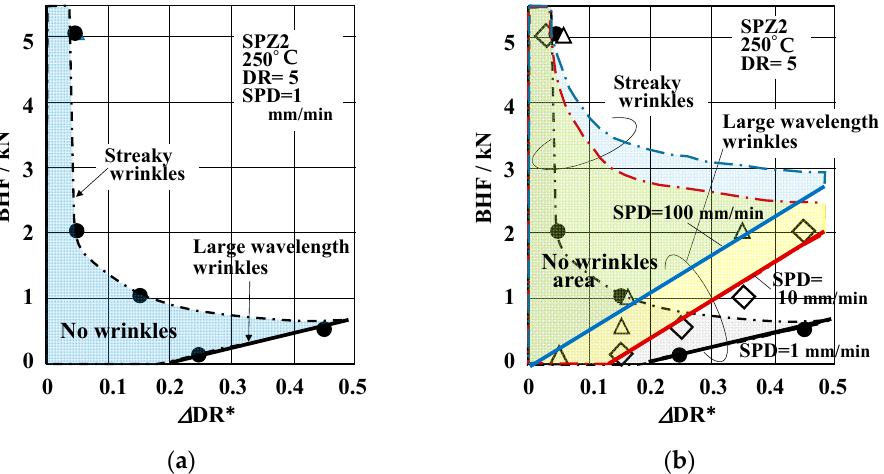
Figure 4. Effects of BHF and SPD on the occurrence of flange wrinkles under constant BHF and SPD in warm superplastic deep drawing (DR = 5). 〇 : SPD (mm/min) = 1, ◇ : SPD = 10, △: SPD = 100, solid line: large wavelength wrinkle mode, dashed line: streaky wrinkle mode. ( a ) Wrinkle limit diagram at SPD=1 mm/min; ( b ) effect of SPD on wrinkle limit diagram.